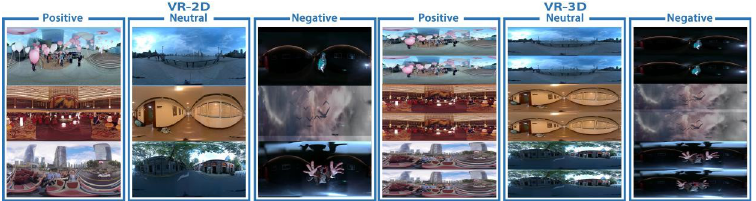
Fig 2. The experimental materials were divided into the VR-2D group and VR-3D group. The positive, neutral and negative VR video materials have 20 different contents.